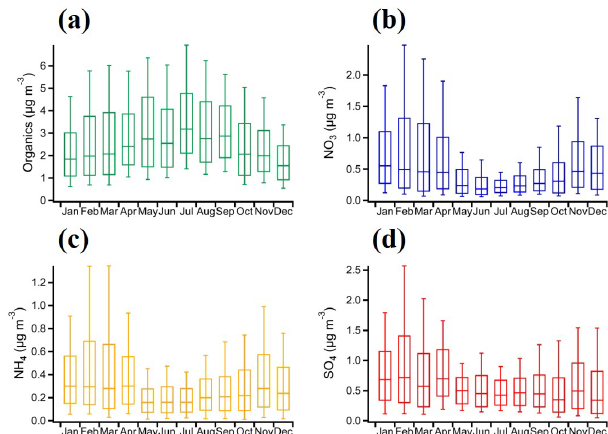
Figure 4. Monthly variation in the NR-PM 1 constituents (organics, NO 3 , NH 4 , and SO 4 ) measured by ACSM. In each box, the mid-line shows the median value for each x value component, the whisker bottom and top correspond to the 10th and 90th percentiles, and the box top and bottom correspond to the 75th and 25th percentiles, respectively.